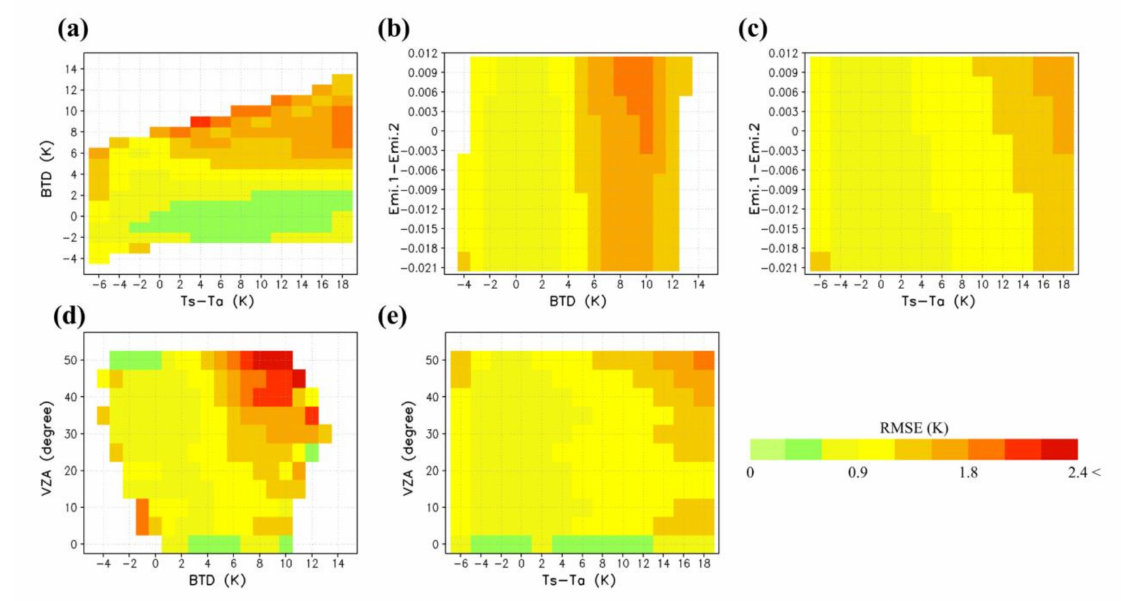
Figure 6. Distribution of RMSEs for the LST retrieval algorithms based on the di ff erent impacting factors: ( a ) brightness temperature di ff erence (BTD) and surface lapse rate; ( b ) emissivity di ff erence ( ∆ ε ) and BTD; ( c ) ∆ ε and surface lapse rate; ( d ) satellite viewing zenith angle (VZA) and BTD; ( e ) VZA and surface lapse